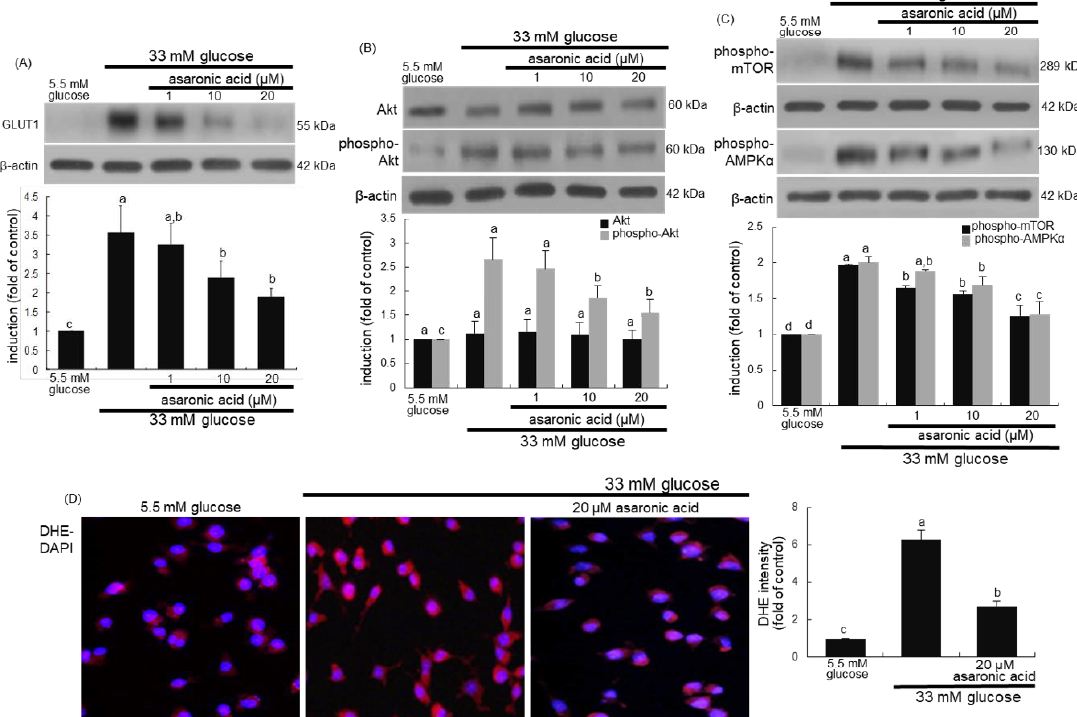
Figure 7. Inhibition of induction of GLUT1, phospho-Akt, phospho-mTOR, and phospho-AMPKα by asaronic acid ( A–C ), and blockade of ROS production by 20 μM asaronic acid ( D ). J774A.1 macrophages were exposed to 33 mM glucose in the absence and presence of 1-20 μM asaronic acid for 48 h. Cell lysates were subject to 8–12% SDS-PAGE and Western blot analysis with a primary antibody against GLUT1, Akt, phospho-Akt, phospho-mTOR, and phospho-AMPKα. β-Actin antibody was used as an internal control. The bar graphs (mean ± SEM, n = 3) in the panels represent quantitative results of the upper blot bands obtained from a densitometer. Mean values in respective bar graphs not sharing a same lower-case alphabet letter are significantly different at p < 0.05. For the measurement of ROS production ( D ), reddish DHE staining was conducted in J774A.1 macrophages exposed to 33 mM glucose in the presence of 20 μM asaronic acid. Nuclear staining was done with DAPI (blue). Magnification: 200-fold.